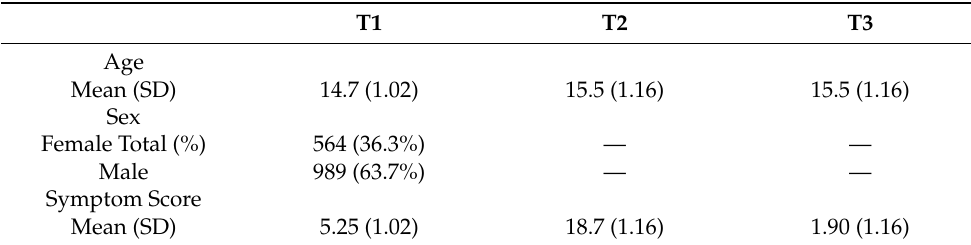
Table 1. Demographic Information by time point ( n =